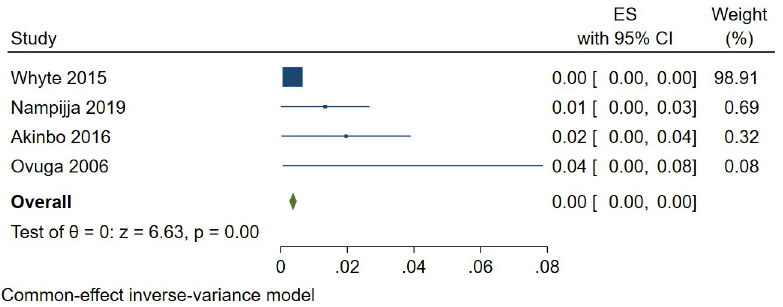
Fig 2. Forest plot showing the pooled prevalence of depression in Uganda following sensitivity